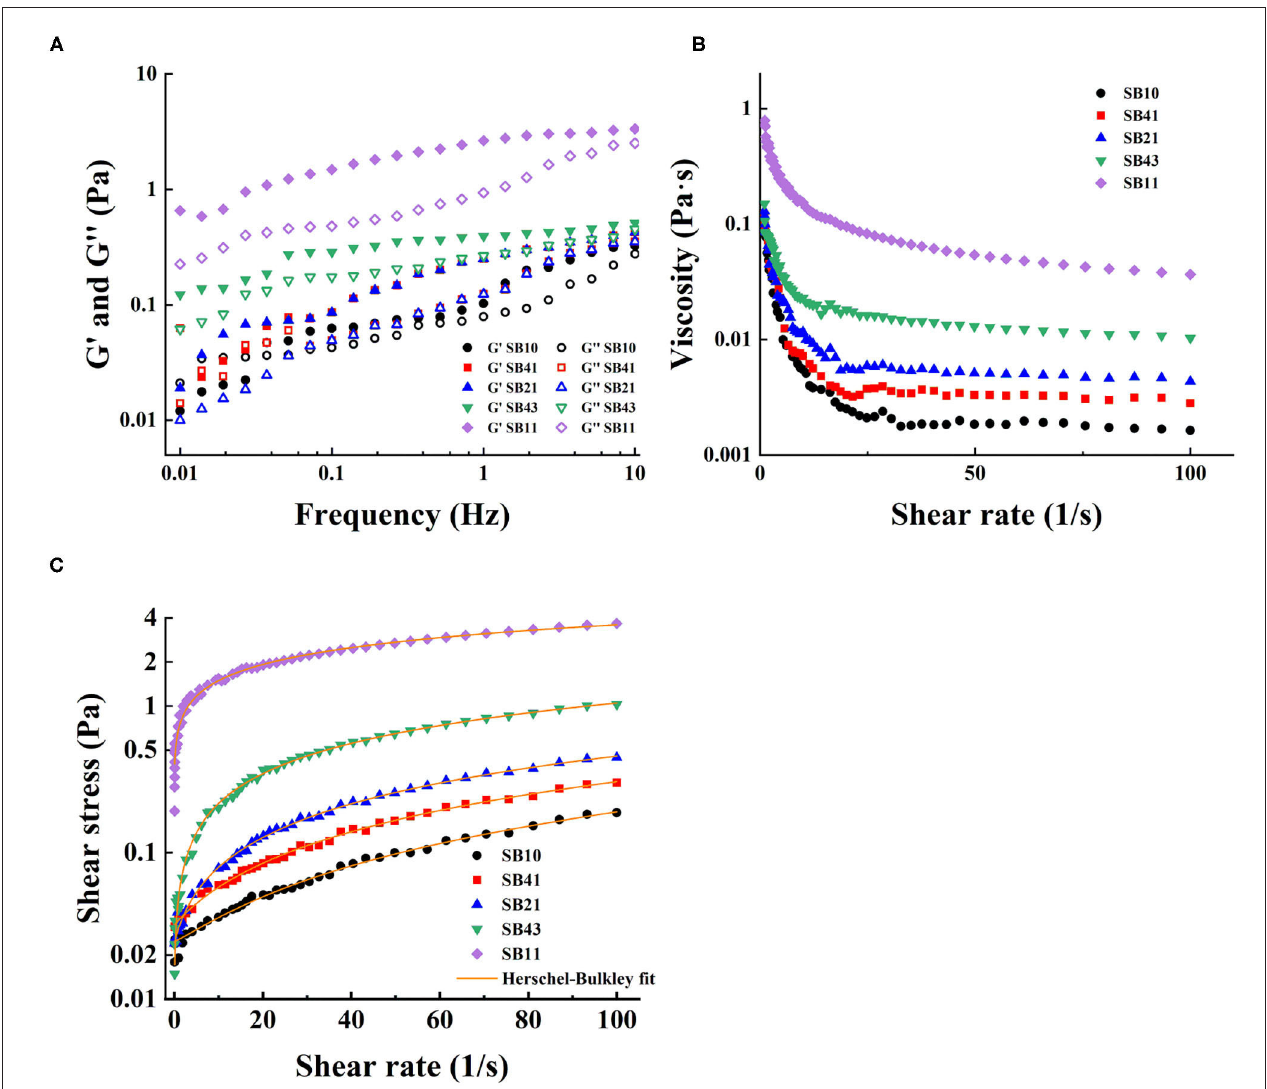
FIGURE 6 | Dynamic frequency sweep of the emulsions (A) . Shear-rate dependence of the viscosity of the emulsions at various SPI/BPC ratios (B) . Plots of shear stress vs. shear rate for the emulsions. The solid lines are the lines of best fit to the Herschel-Bulkeley model (C) .